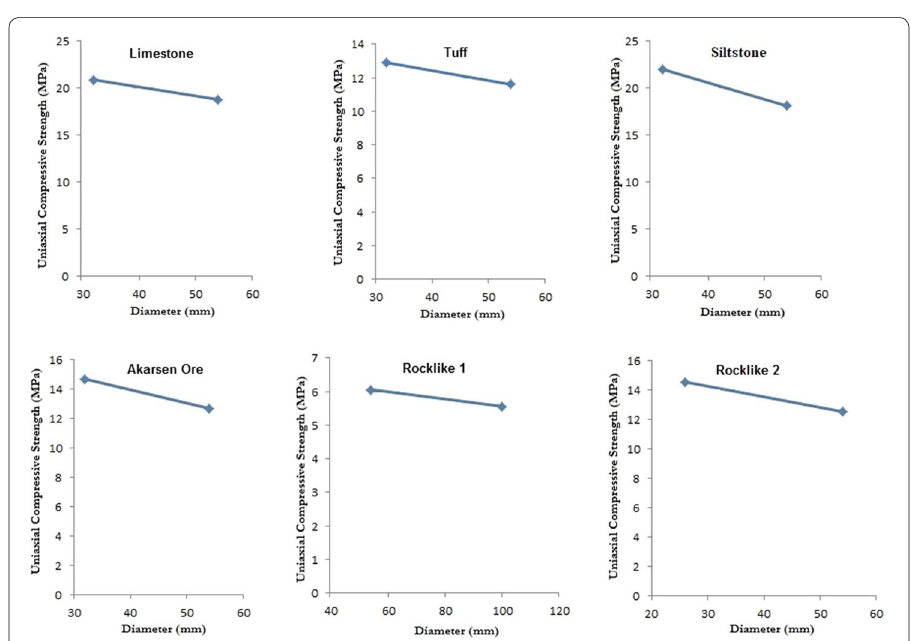
Fig. 7 UCS values under same deformation rate